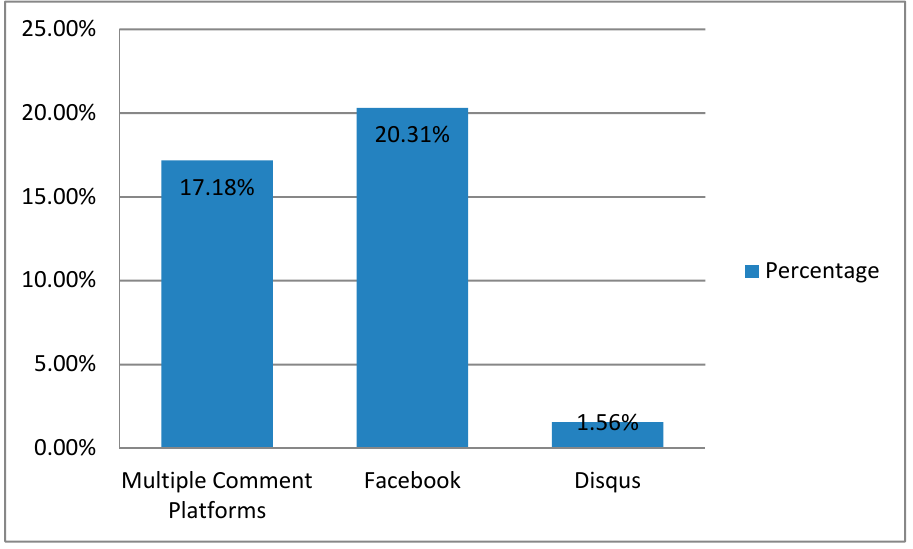
Figure 6. The Results of the Study for the Cypriot News Websites for the Commenting Platforms (n = 128).